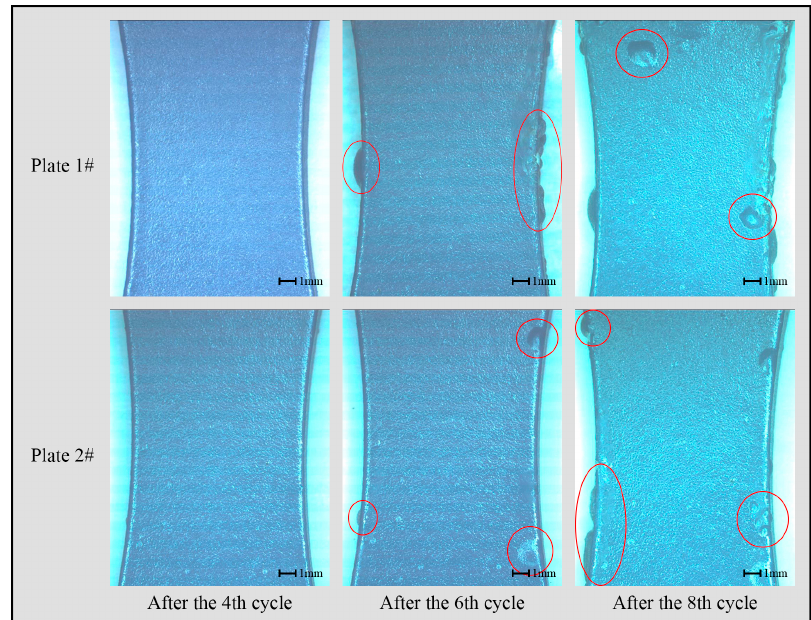
Figure 3. Macro-morphology of the specimens.